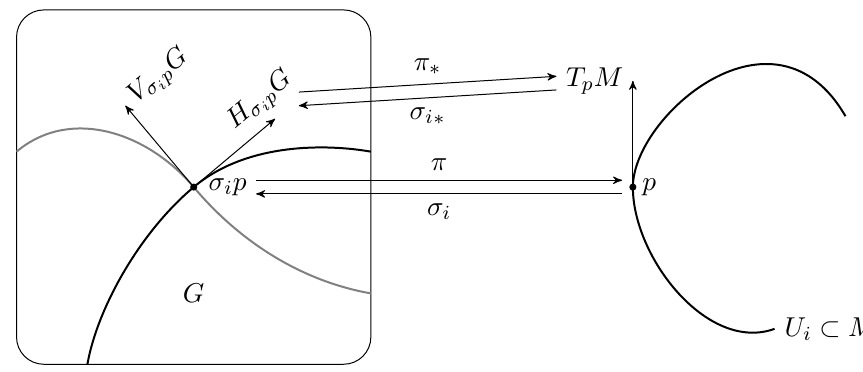
Figure 1 . The curved, black line represents all directions in G which solve the SC. Their tangent space forms the horizontal subspace de(cid:12)ned by the connection one-from ! as ! ( X ) = 0 8 X 2 HG . All tangent vectors on the physical space M are mapped to HG by the di(cid:11)erential map (cid:27) i appropriate patch U i (cid:26) M